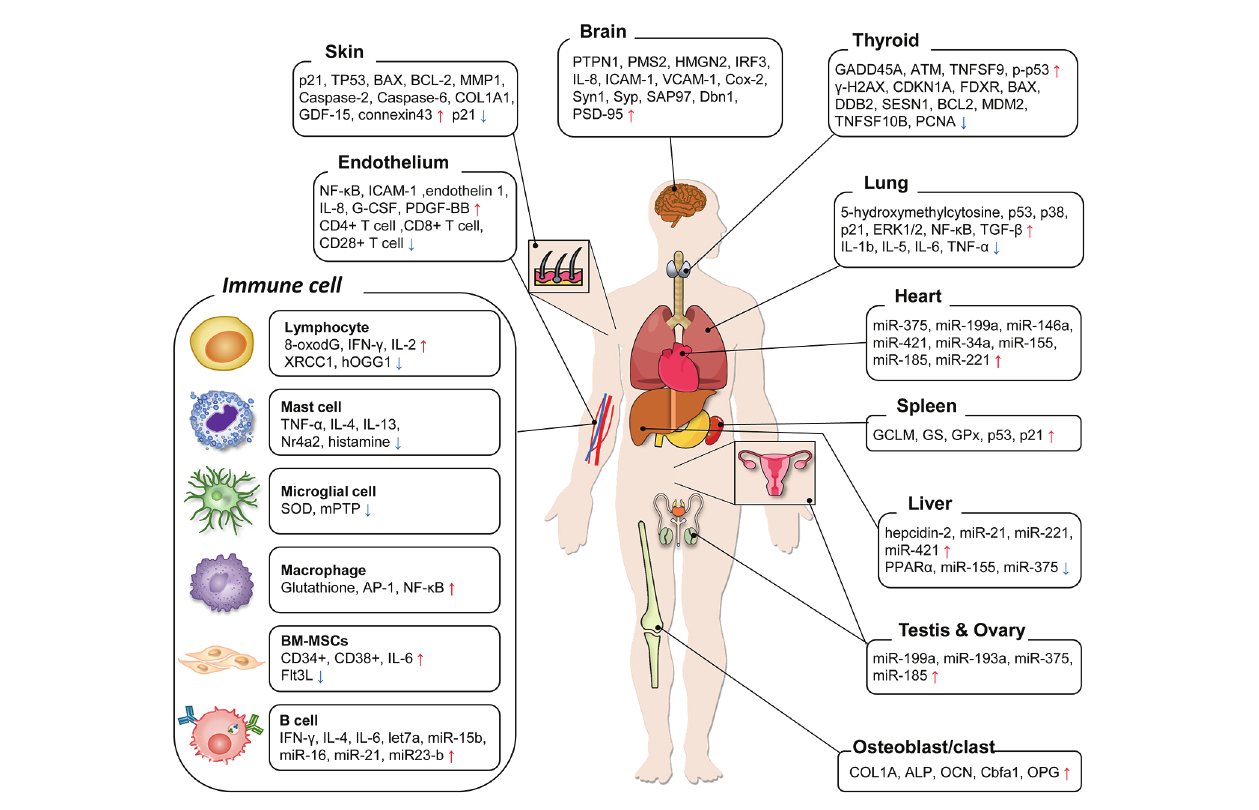
FIGURE 1 | A diagram summarizing organ-specific biological markers by low-dose radiation (LDR) exposure. The molecular markers suggested in previous LDR studies were categorized. For each organ, the markers were enumerated following the expression change after LDR exposure and increase/decrease was marked as arrows ( ↑ / ↓